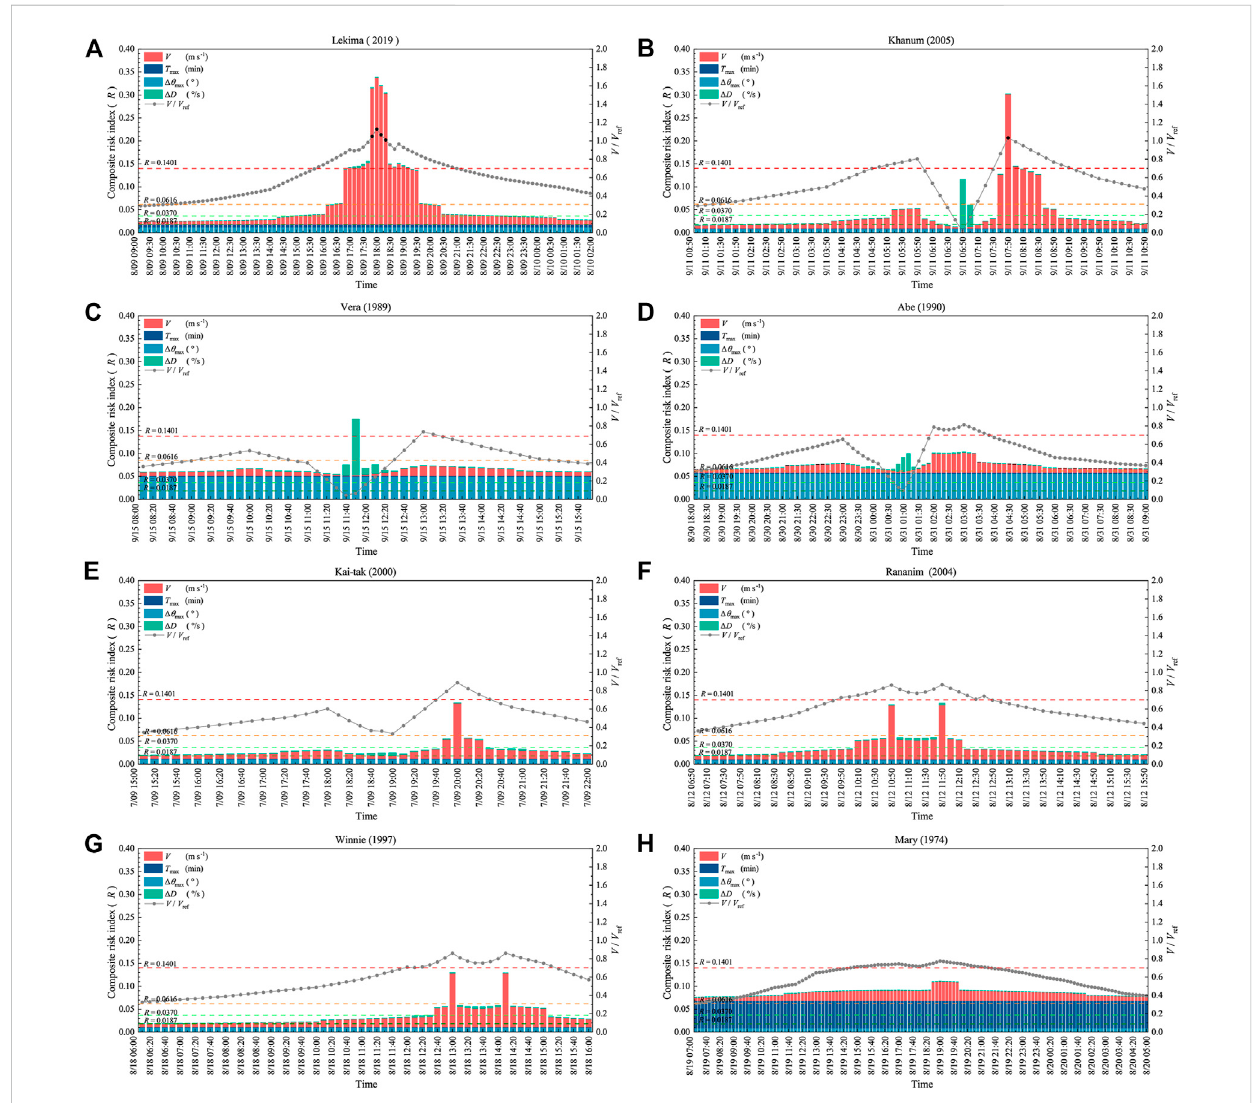
Time series of tropical cyclone risk above the relatively high level (bars) and the V/V ref time series (dotted line). The name of tropical cyclones in panels (A,B,C,D,E,F,G and H) are Lekima, Khanum, Vera, Abe,Kai-tak, Rananim, Winnie, and Mary, respectively. The time step is10 min, V istheactual10- min mean wind speed of tropical cyclones, V ref is reference 10-min mean wind speed of Type I wind turbines (taken as 50 m s − 1 ). Gray points indicate V/ V ≤ 1, black points indicate V/V > ref ref